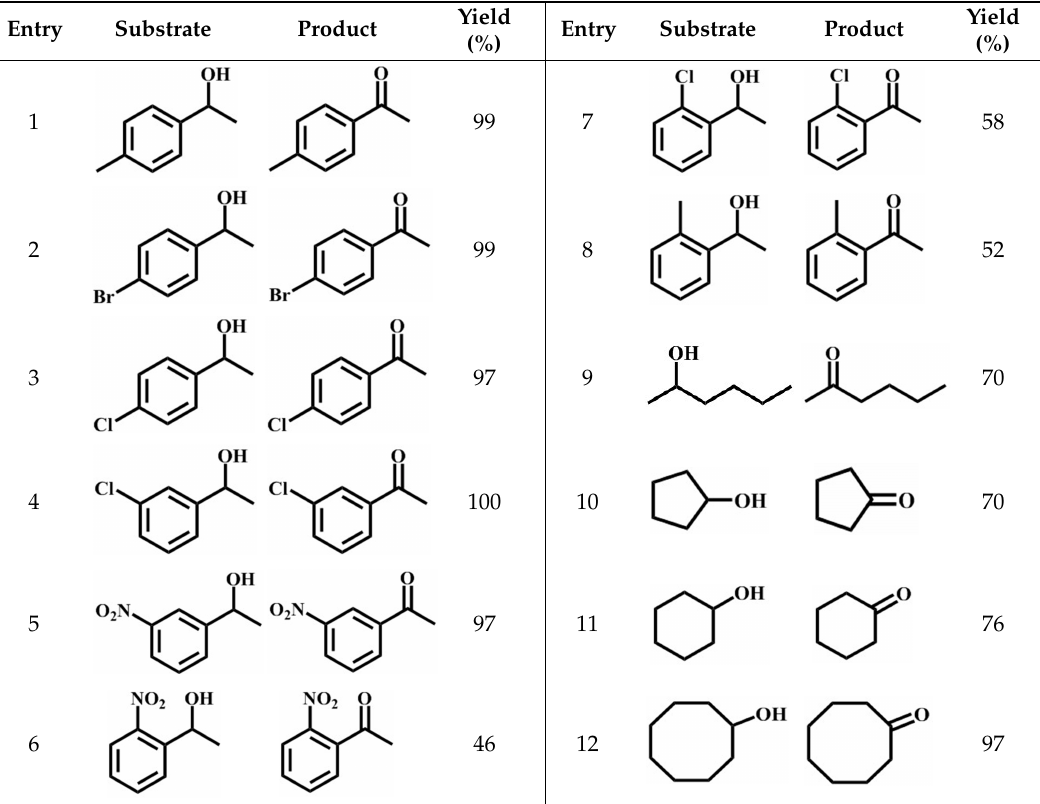
Table 1. Substrate scope for aromatic secondary alcohols in the context of the optimal conditions a .